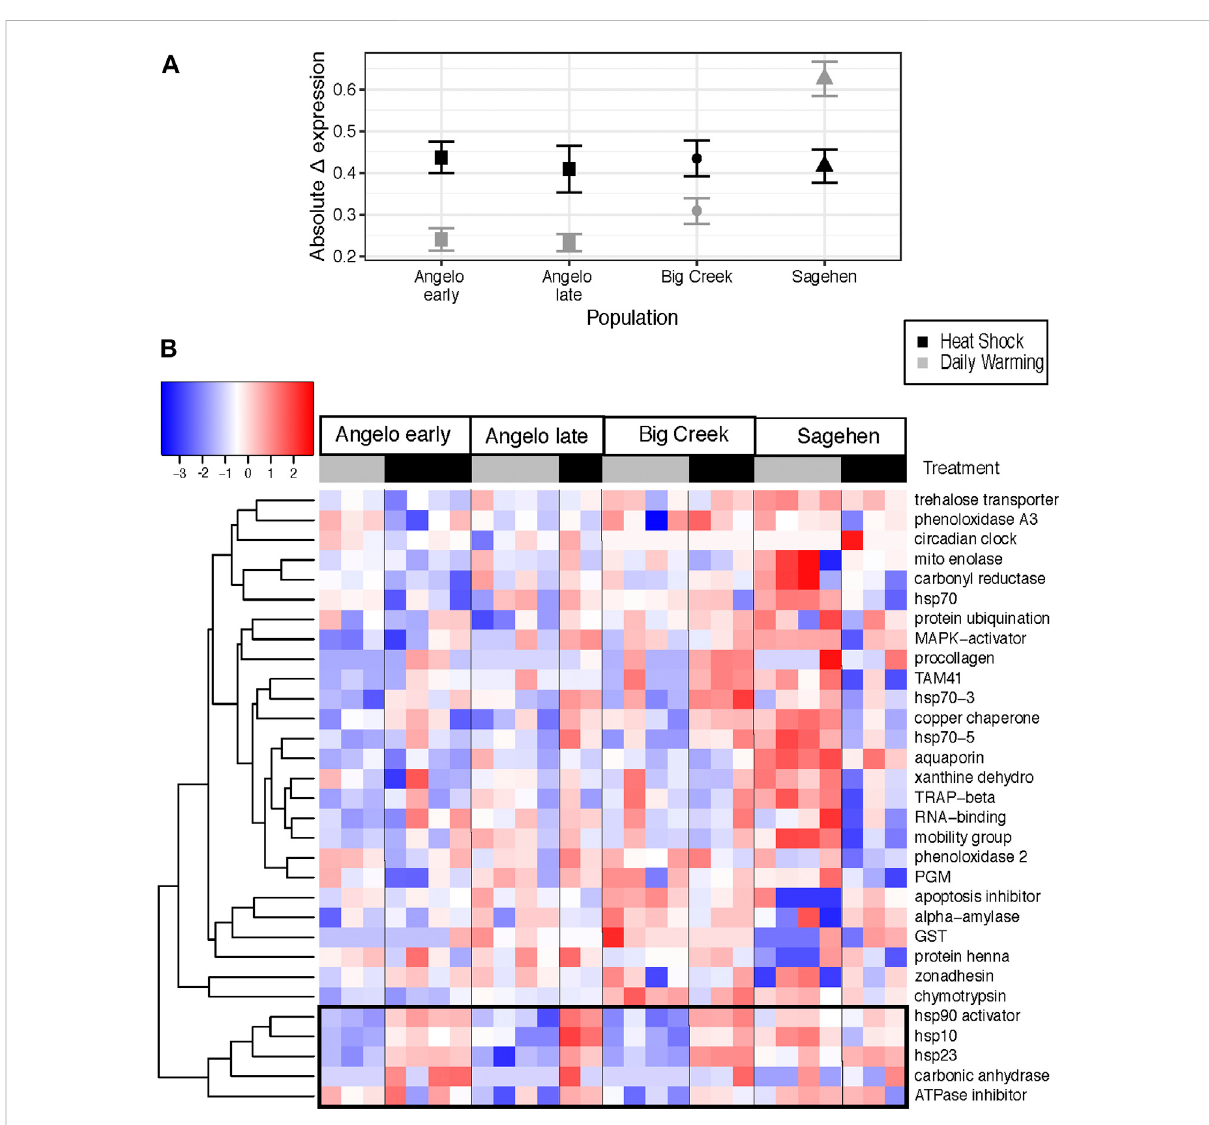
FIGURE 3 Change in expression between cool control and warming treatments for Dicosmoecus gilvipes from three California streams (A) Mean ± standarderroroftheabsolutechangeinexpression( Δ expression)fromthecontrolateachsiteandtreatment.Graypointsrepresentthedailystream warmingtreatment,andblackpointsrepresenttheheatshocktreatment. (B) Heatmapofdifferenceingenetranscriptabundancerelativetothecool control treatment. Genes are arranged in rows and grouped by similarity of induction value (dendrogram). Each column is an individual caddis fl y, labeled by its warming treatment. Black and grey bars correspond to the daily warming treatment and heat shock, respectively. The colors of the heat map cells represent the magnitude and direction of the change in expression, scaled and centered by row. The black box highlights a cluster of genes with similar expression patterns (See Figure